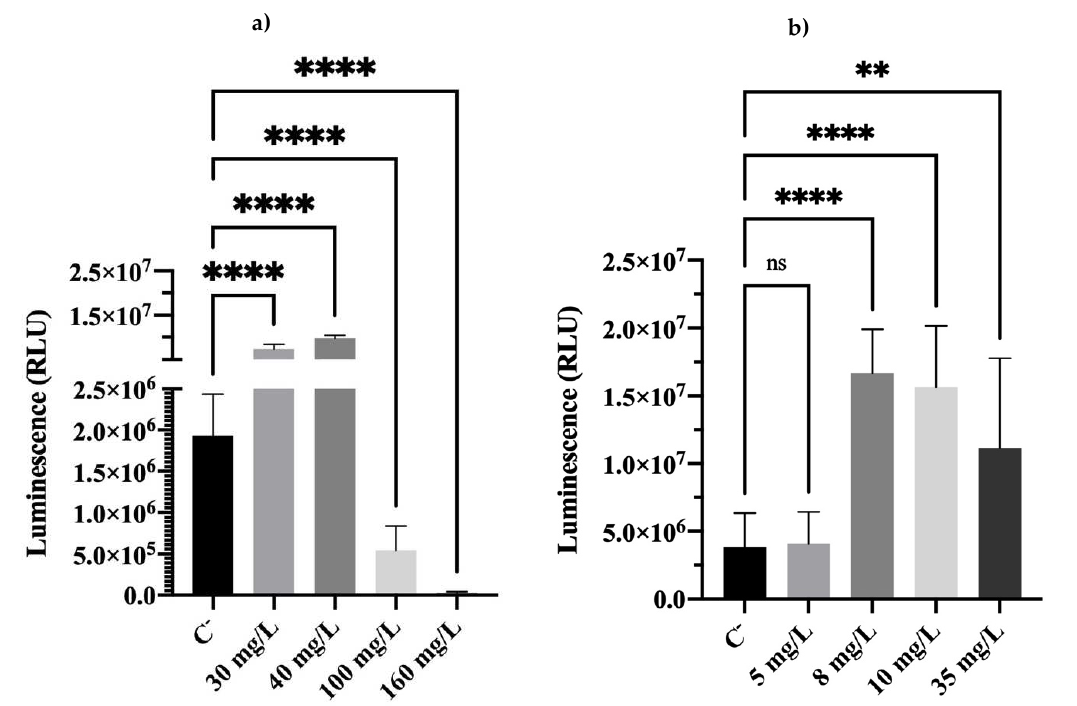
Figure 4. Luminescence of Pseudomonas fluorescens cells after an overnight step in a nutrient medium, resulting from previously exposure to different concentrations of ( a ) BAC and ( b ) DBNPA for 30 min. Controls were performed with untreated cells (C − ). The means ± SD of three independent experiments are presented. “ns” indicates not significant ( p > 0.05), whereas the asterisks indicate statistical significance (** p < 0.01 and **** p < 0.0001), using Tukey’s multiple comparisons test. (RLU: Relative Light Units).